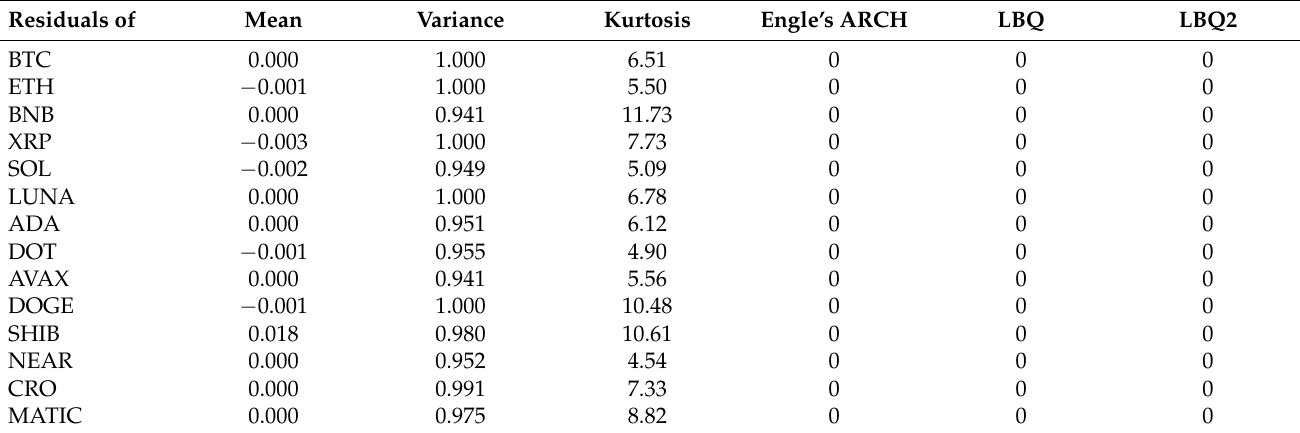
Table 5. Properties of the extracted